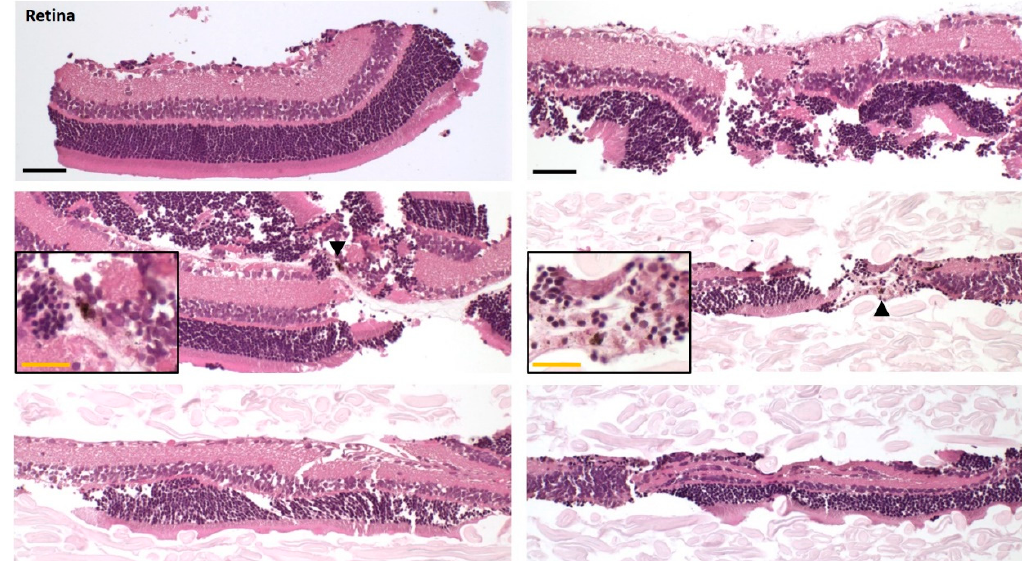
Figure 2. Histology images of retina preparations of several BN rat eyes demonstrating the low cross-tissue contamination observed with the presented separation technique. Black arrowheads show the rarely observed contamination; inserts show these areas magnified. Black bar: 50 µm (applies to all six figures), yellow bar: 25 µm (applies to the insert where shown).